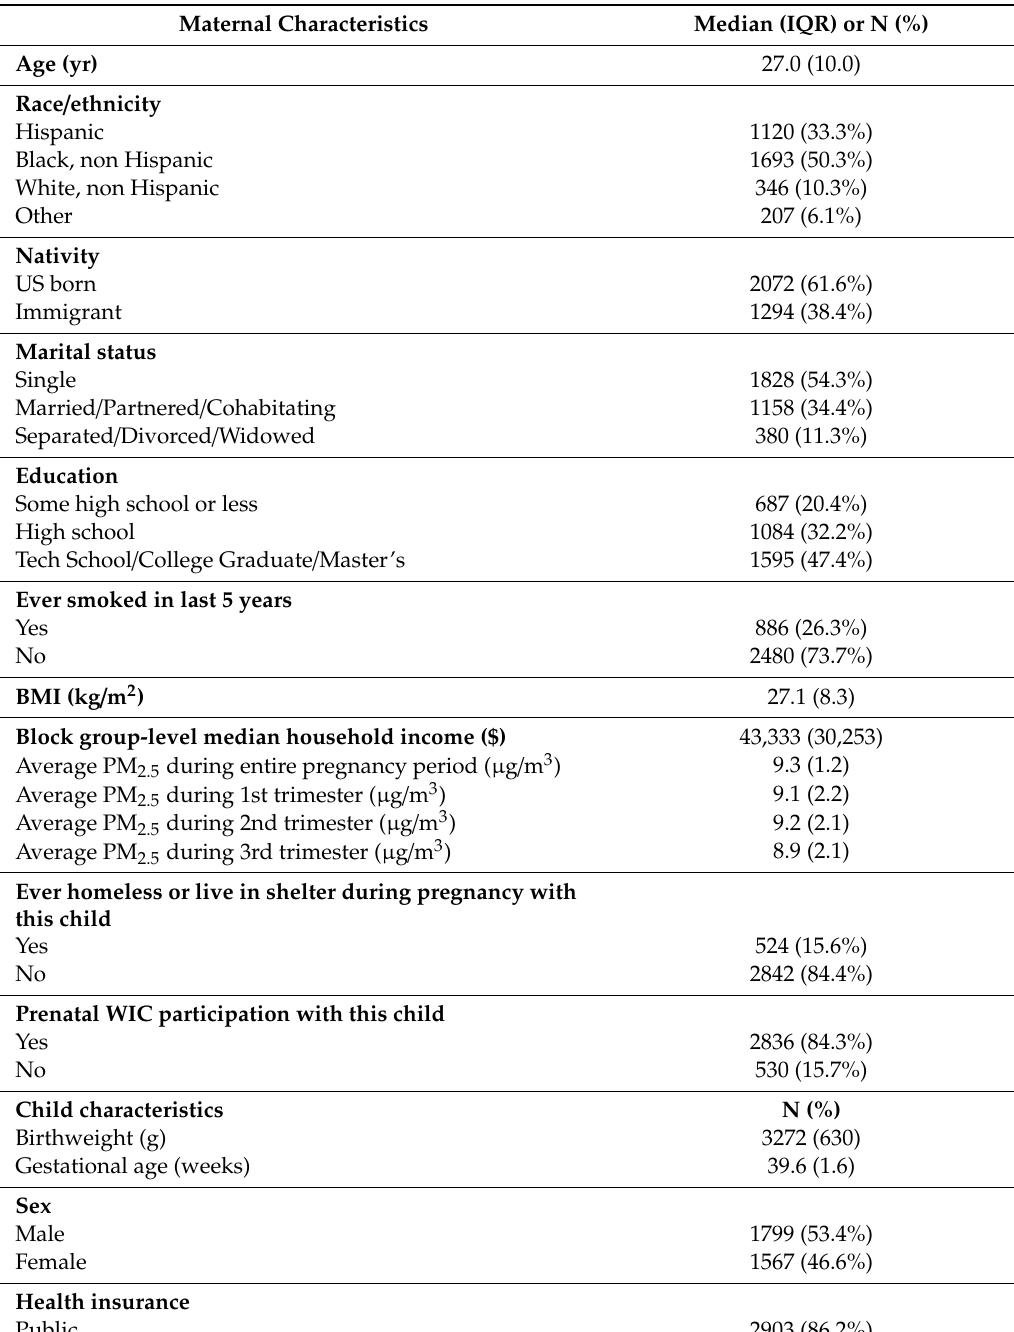
Table 1. Maternal and child characteristics of the Boston-based Children’s HealthWatch cohort (N =